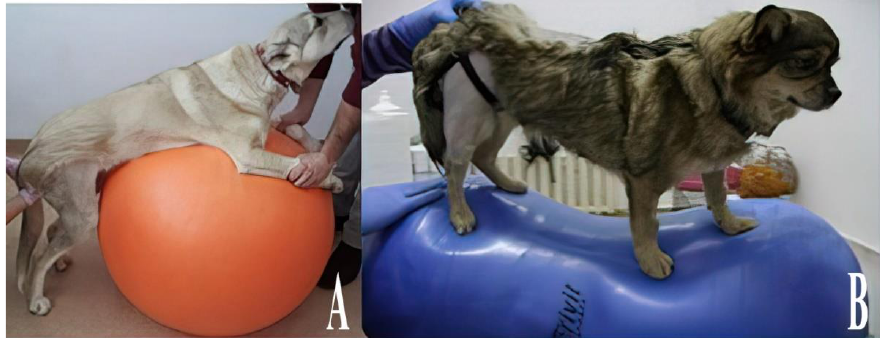
Figure 8. Exercises performed on a physio ball ( A ) and a balance roller ( B ).